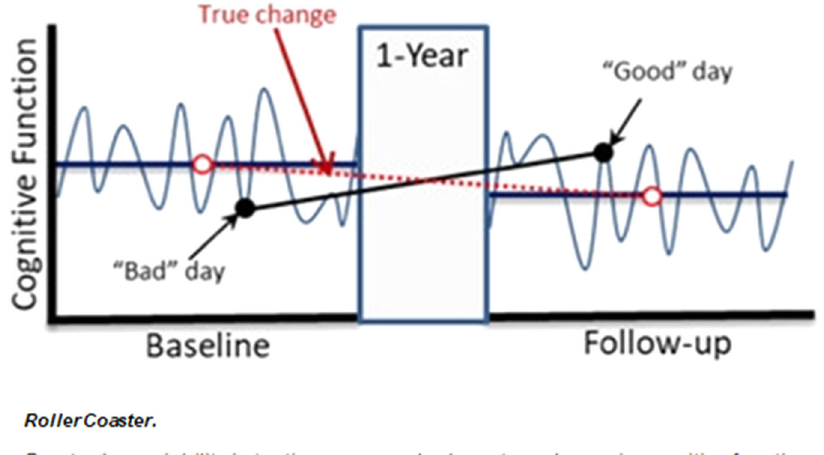
Fig. 1 Day-to-day variability in testing can overshadow true performance due to external factors (environment) and internal factors (anxiety, motivation, etc.). Reprint courtesy of Martin Sliwinsk, permission granted 44